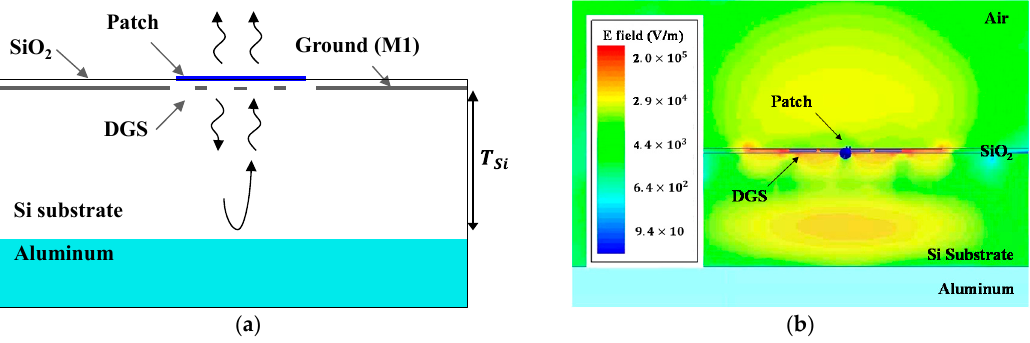
Figure 7. ( a ) Diagram of radiating waves in the proposed antenna. ( b ) E-field distribution of the proposed antenna.